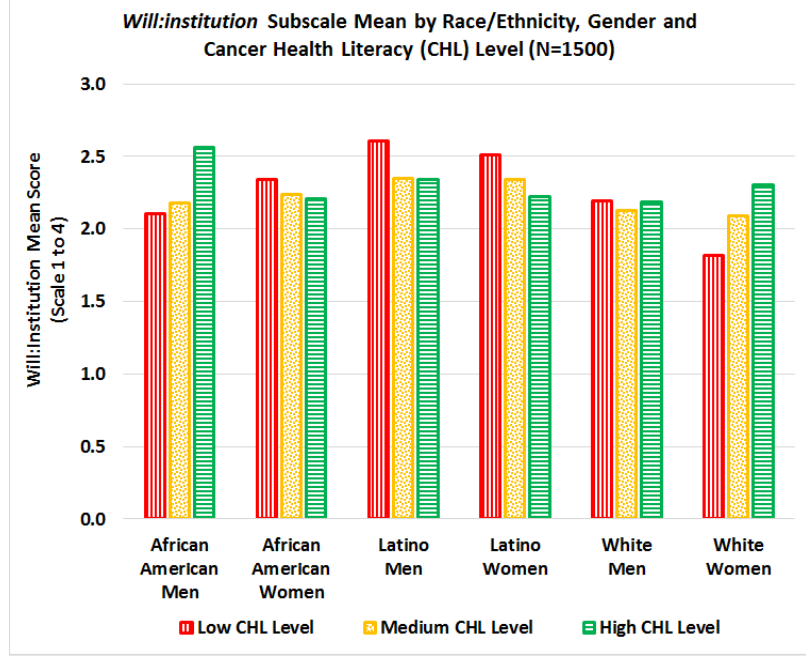
Figure 11. Interaction between cancer health literacy, race/ethnicity, and gender on Will:Institution subscale mean scores.